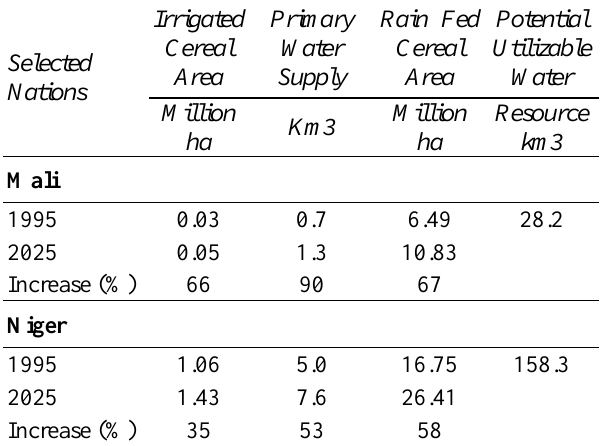
Table 3: Results of the classified images for 1987